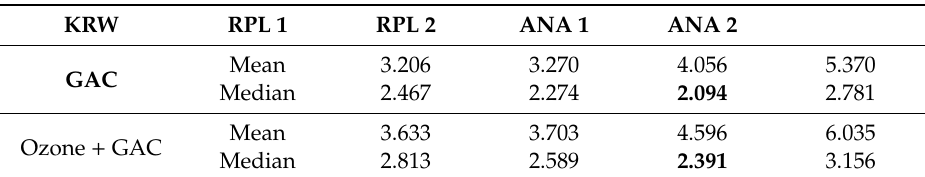
Table 6. Benefits from the four